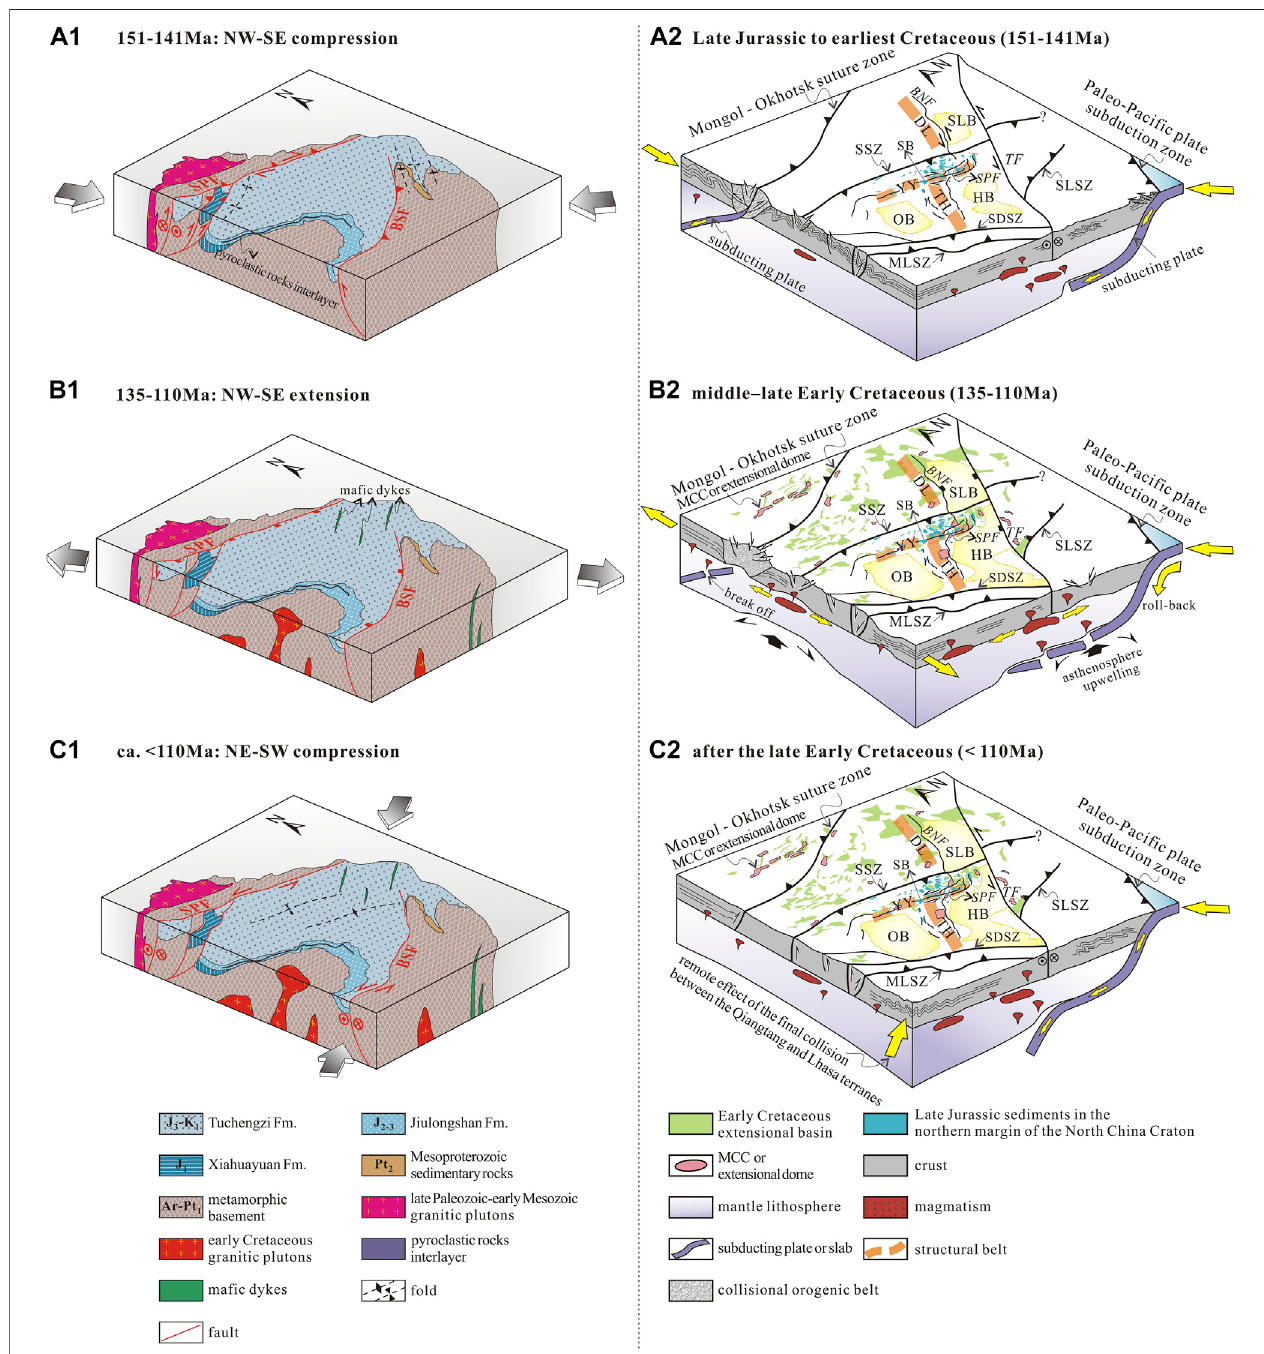
FIGURE 13 | Late Mesozoic tectonic evolution of the Shangyi area (A1 – C1) and possible dynamic mechanisms (A2 – C2) (modi fi ed after Wang et al., 2011; Wang etal.,2017).SLB,SongliaoBasin;HB,HuabeiBasin;OB,OrdosBasin;SSZ,Solonker-Linxisuturezone;SLSZ,Sulusuturezone;SDSZ,Shangdansuturezone;MLSZ, Mianlue suture zone. The rest fi gure captions are the same as Figures 1A,B . See text for more details.